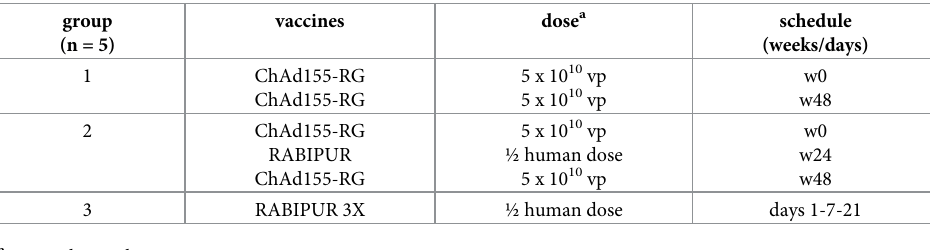
Table 1. NHP vaccination